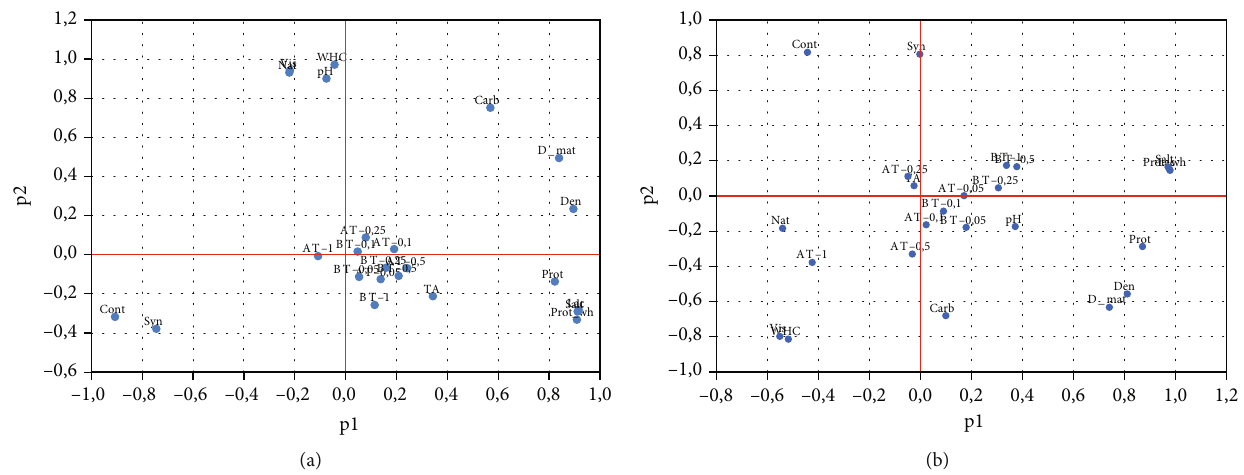
Figure 3: Principal component analysis (PCA) of Symbilact samples added with di ff erent starches after 1 (a) and 28 (b) days of storage. Cont, Nat, А T-0.05, А T-0.1, А T-0.25, А T-0.5, А T-1, BT-0.05, BT-0.1, BT-0.25, BT-0.5, and BT-1 are Symbilact samples. Prot: protein; Prot_wh: protein in whey; Carb: carbohydrates; Lac: lactose; salt: salts; D_mat: dry matter; Den: density; TA: titratable acid, pH; Syn: syneresis, WHC; Vis: